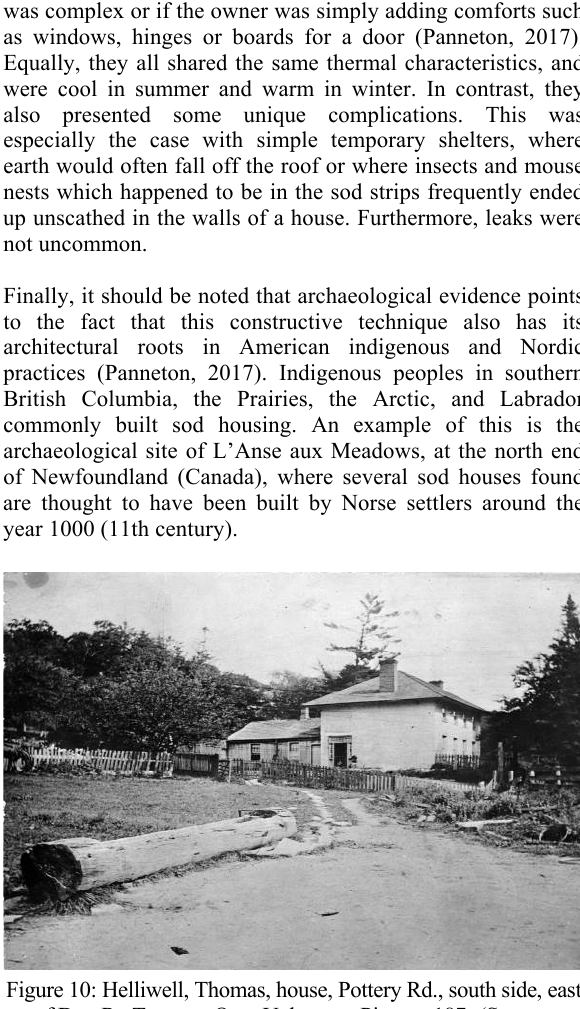
Figure 9. Sod house in Alberta in 1911 “That J. H. GANO Wainwright Alberta” (Source: jasonwoodhead23).